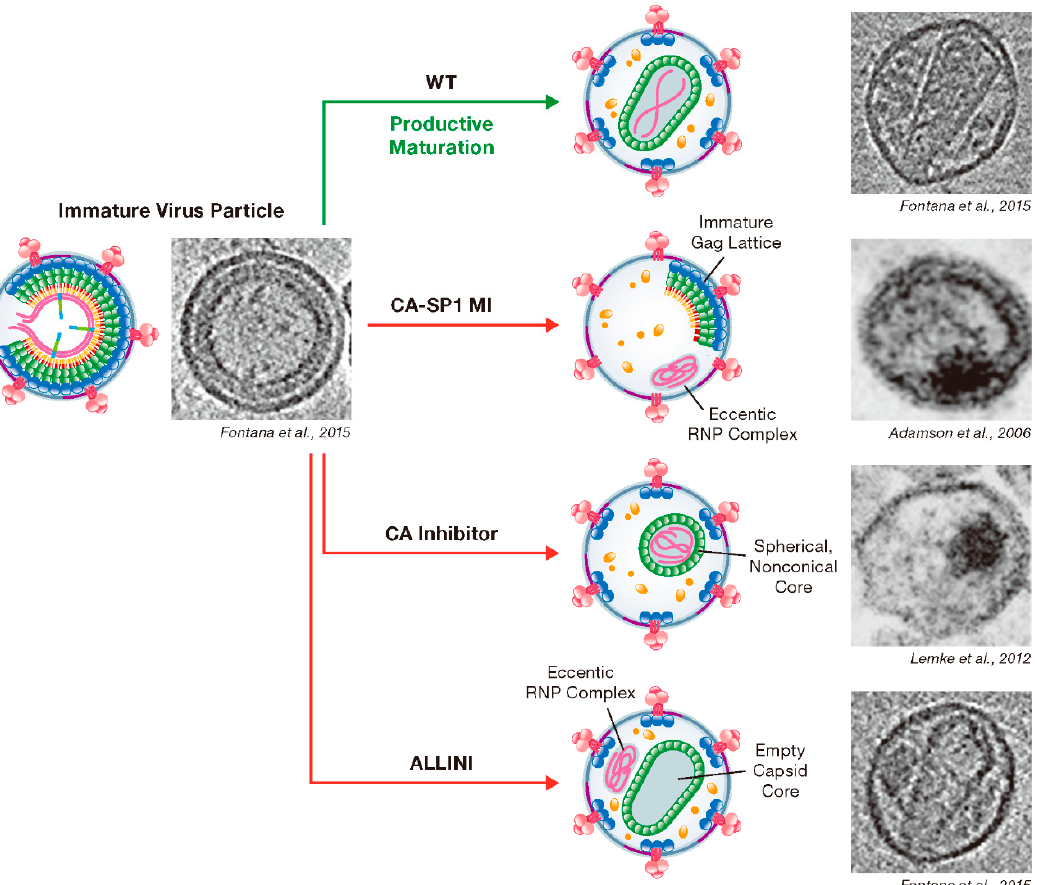
Figure 8. MIs exhibit diverse mechanisms of action. Productive maturation of HIV-1 particles can be inhibited by blocking multiple key steps such as CA-SP1 cleavage (CA-SP1 MIs), mature capsid assembly (CA inhibitors), and ribonucleoprotein (RNP) encapsidation (allosteric integrase inhibitors, ALLINIs). Representative micrographs, obtained by either thin section electron microscopy (EM) or cryo-electron tomography (cryo-ET), are shown, coupled with graphic representations of the EM data. Additional details are provided in the main